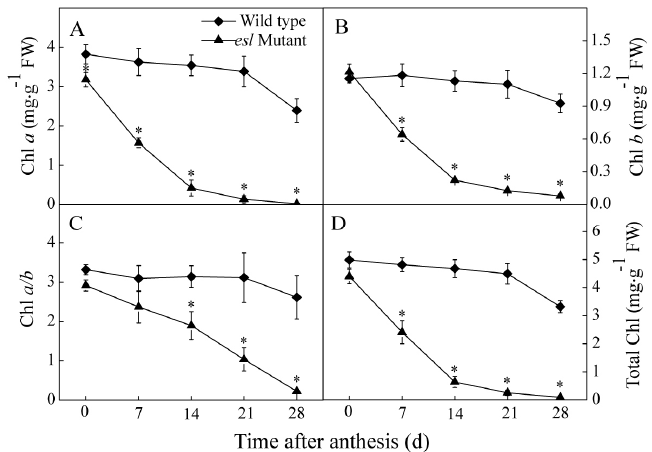
Figure 4. Genotype-dependent differences in ( A ) chlorophyll (Chl) a , ( B ) Chl b , ( C ) Chl a / b , and ( D ) total Chl for the flag leaves of the two rice genotypes during the grain-filling stage. Vertical bars represent standard errors ( n = 3). The asterisks represent significant differences between the esl mutant and its wild-type cultivar (* p < 0.05).